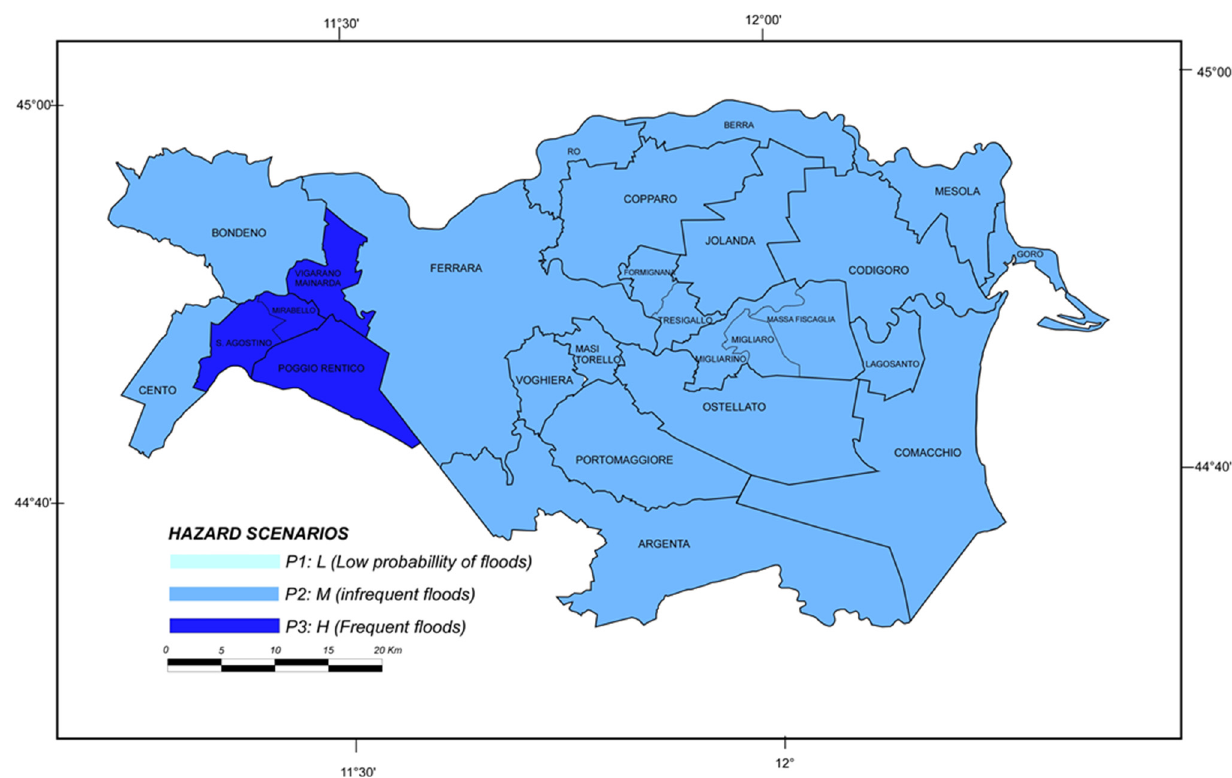
Figure 3. Map of the flood hazard for the province of Ferrara in terms of probability of flood.